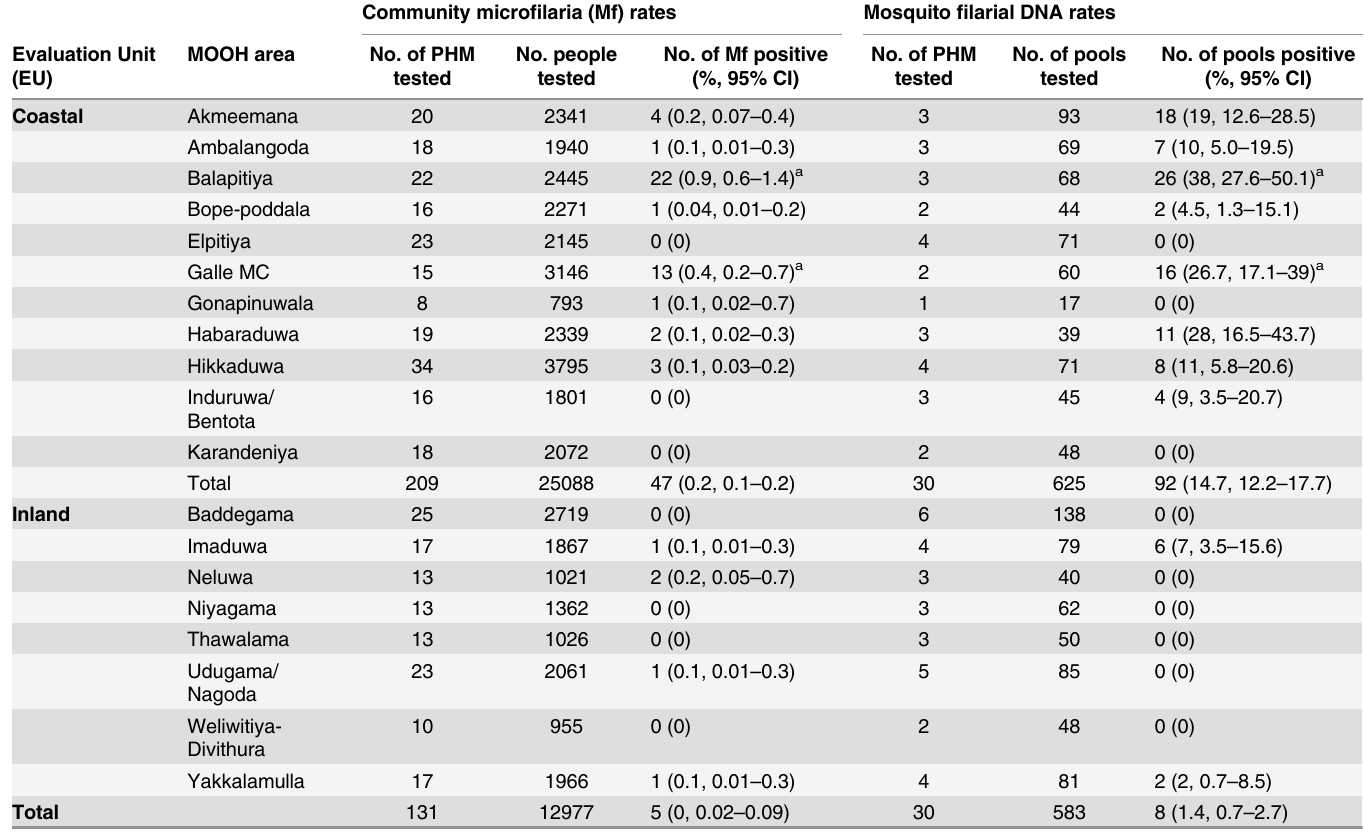
Table 4. Human infection rates and parasite DNA rates from 19 MOOH areas in Galle, Sri